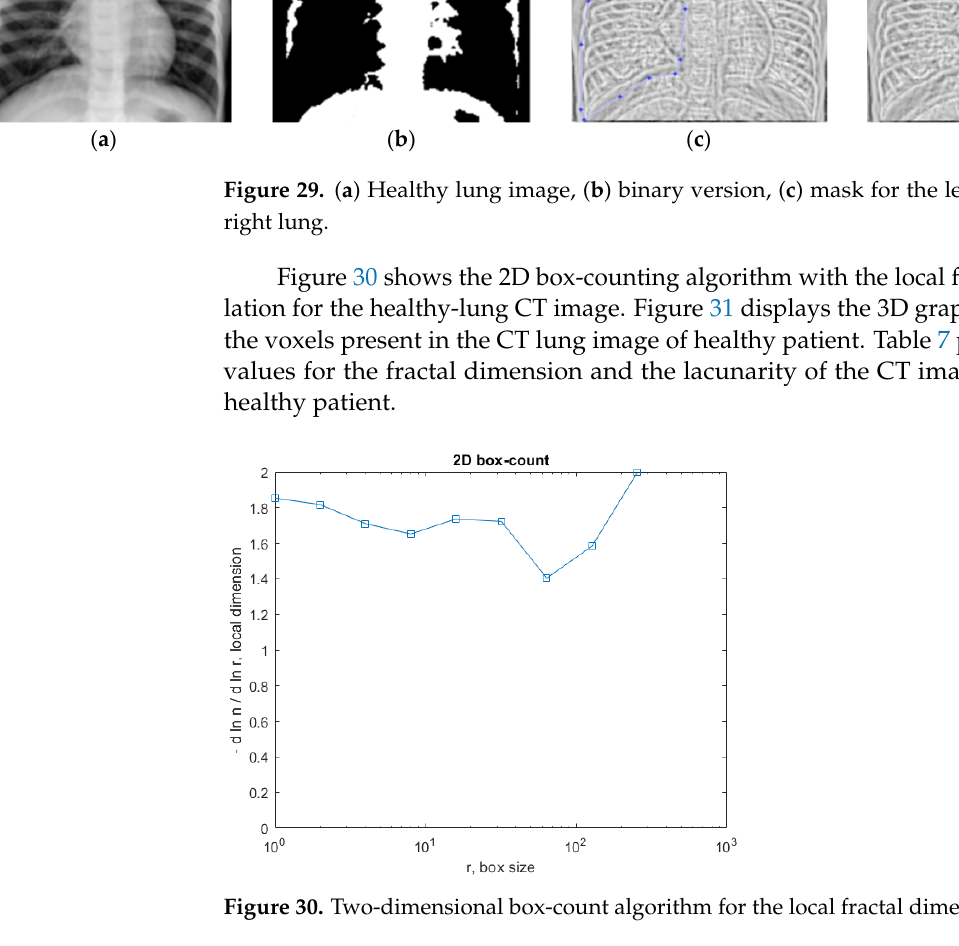
Figure 31. Three-dimensional graphical representation of voxels. Table 7. Calculation of fractal indicators for the healthy lung patient (HLP) .